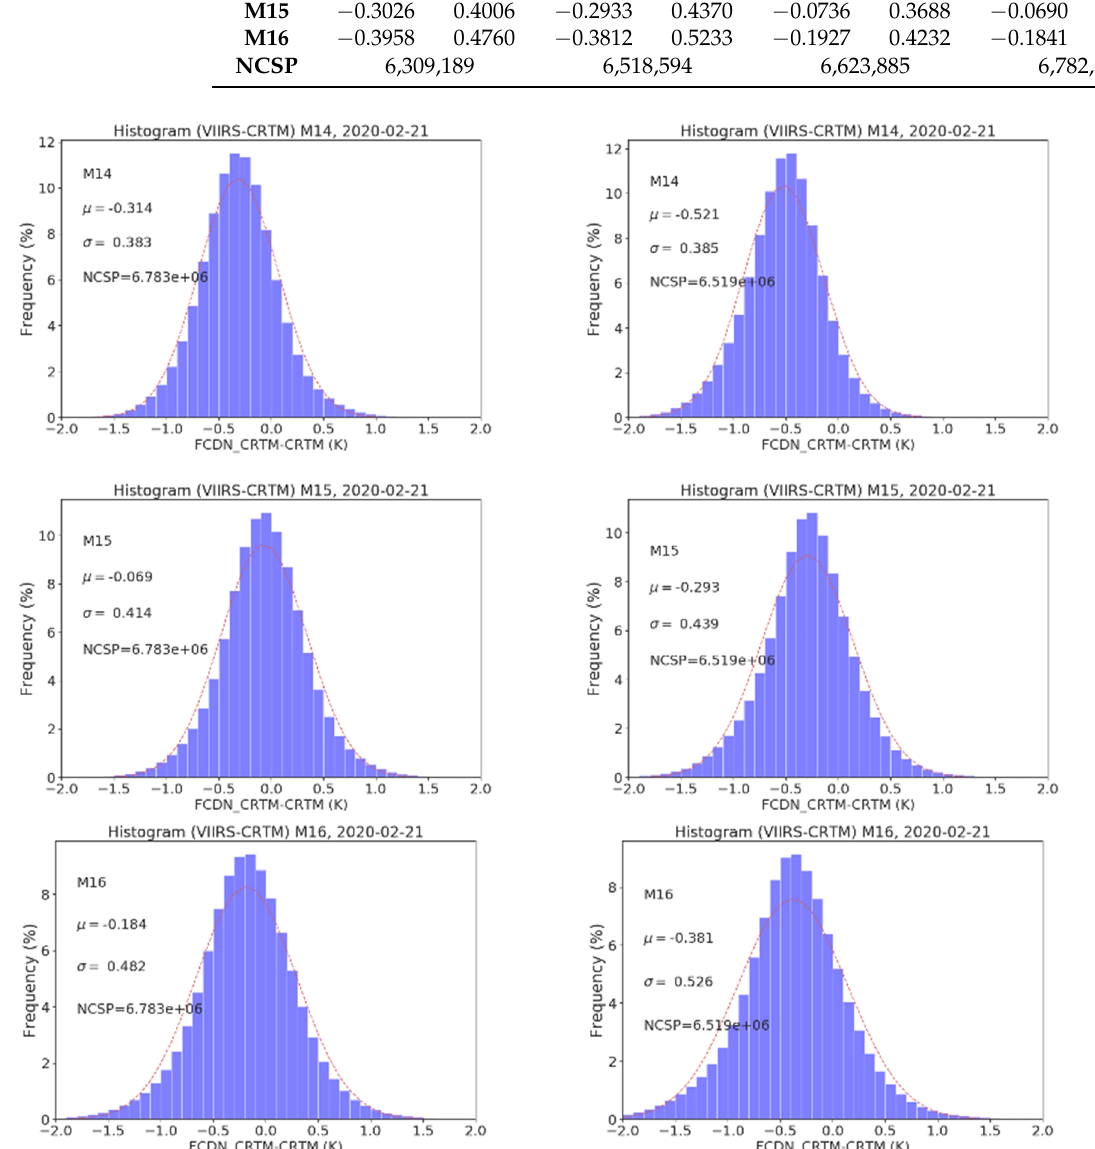
Figure 3. Histograms of the O-M biases on 21 February 2020 for VIIRS M14 ( top ), M15 ( middle ), and M16 ( bottom ), using FCDN_CSM as clear-sky identification for both daytime (left) and nighttime (right).